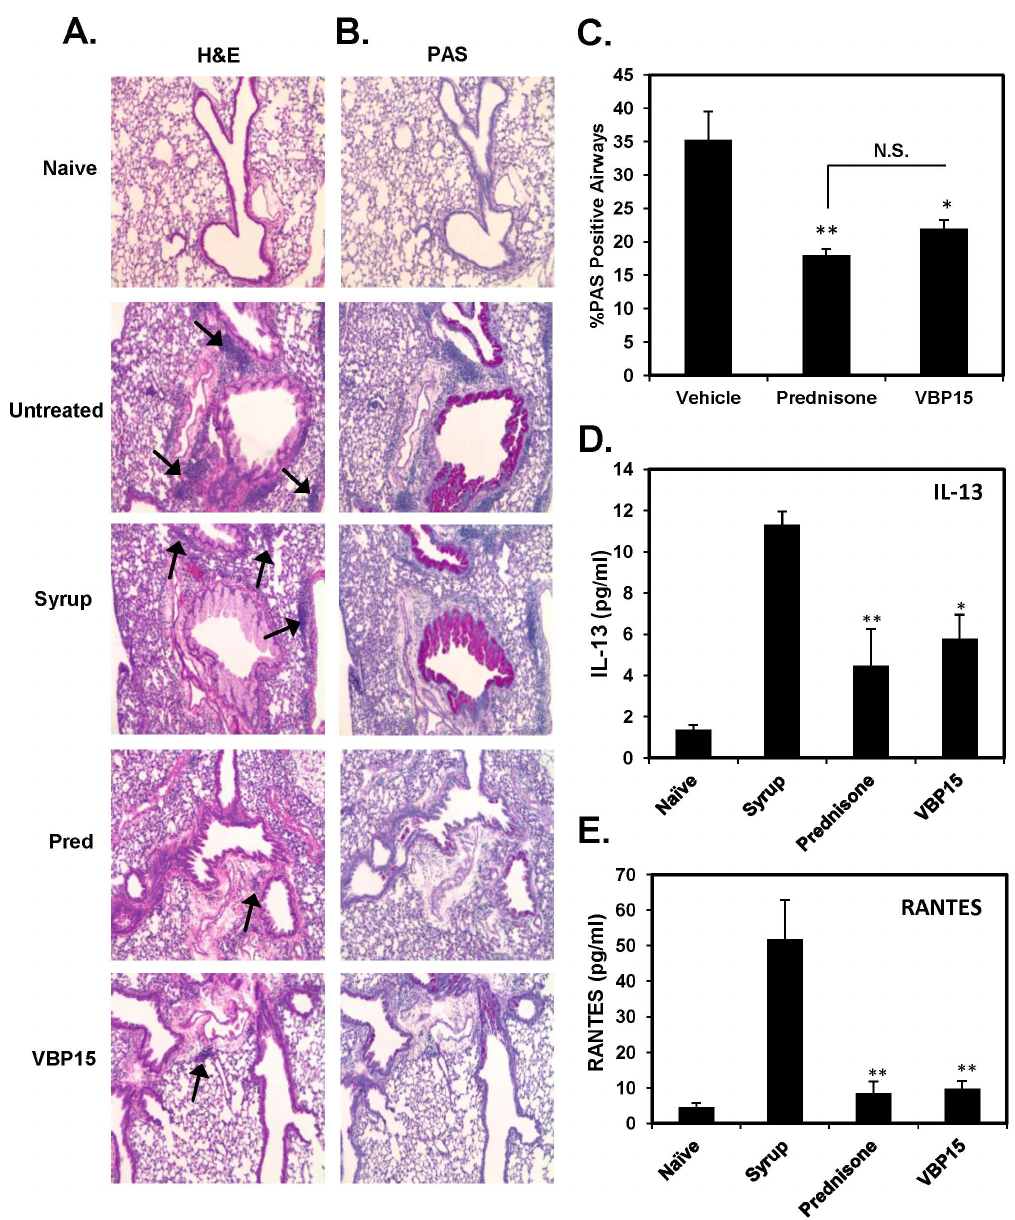
Figure 3. VBP15 reduces acute allergic lung inflammation. OVA-challenged mice were either left untreated or treated with oral doses of prednisone, VBP15 (20 mg/kg), or cherry syrup alone daily for 6 days. A group of non-challenged mice (naı¨ve) was included in order to assess basal inflammatory parameters. Perfused whole lungs were processed for histological analysis and stained with H&E (A) or PAS (B). Images (10 6 magnification) represent areas of tissue surrounding bronchioles. Arrows on H&E sections indicate inflammatory foci. Percentage of PAS positive airways were counted via bright field microscopy (C). Bar graph represents mean ( 6 SE)% PAS positive airways. * p , .05; ** p , 0.01 compared to the vehicle control group with n=5 mice per group. IL-13 (D) and RANTES (E) were measured in BAL fluid by flow cytometric bead array. Bar graphs represent mean ( 6 SE) cytokine concentration values. * p , .05; ** p , 0.01 compared to syrup group with n=5 mice per group.